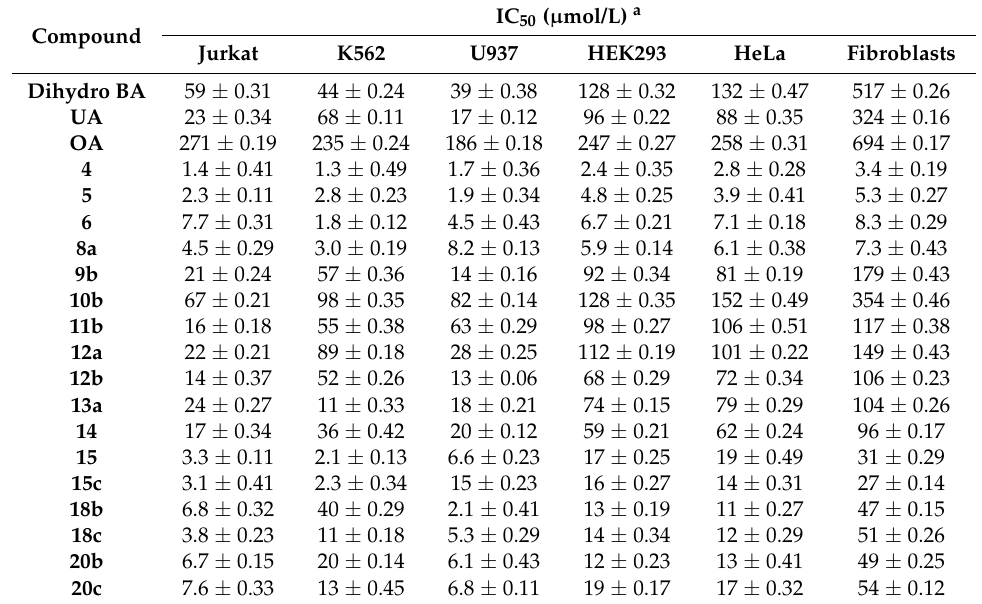
Table 1. Cytotoxicity of dihydrobetulinic-, ursolic- and oleanolic acids and compounds 4 – 6 , 8a , 9b – 12b , 12a , 13a , 14 , 15 , 15c , 18b , c , and 20b , c against Jurkat, K562, Hek293, HeLa, U937, and normal fibroblast